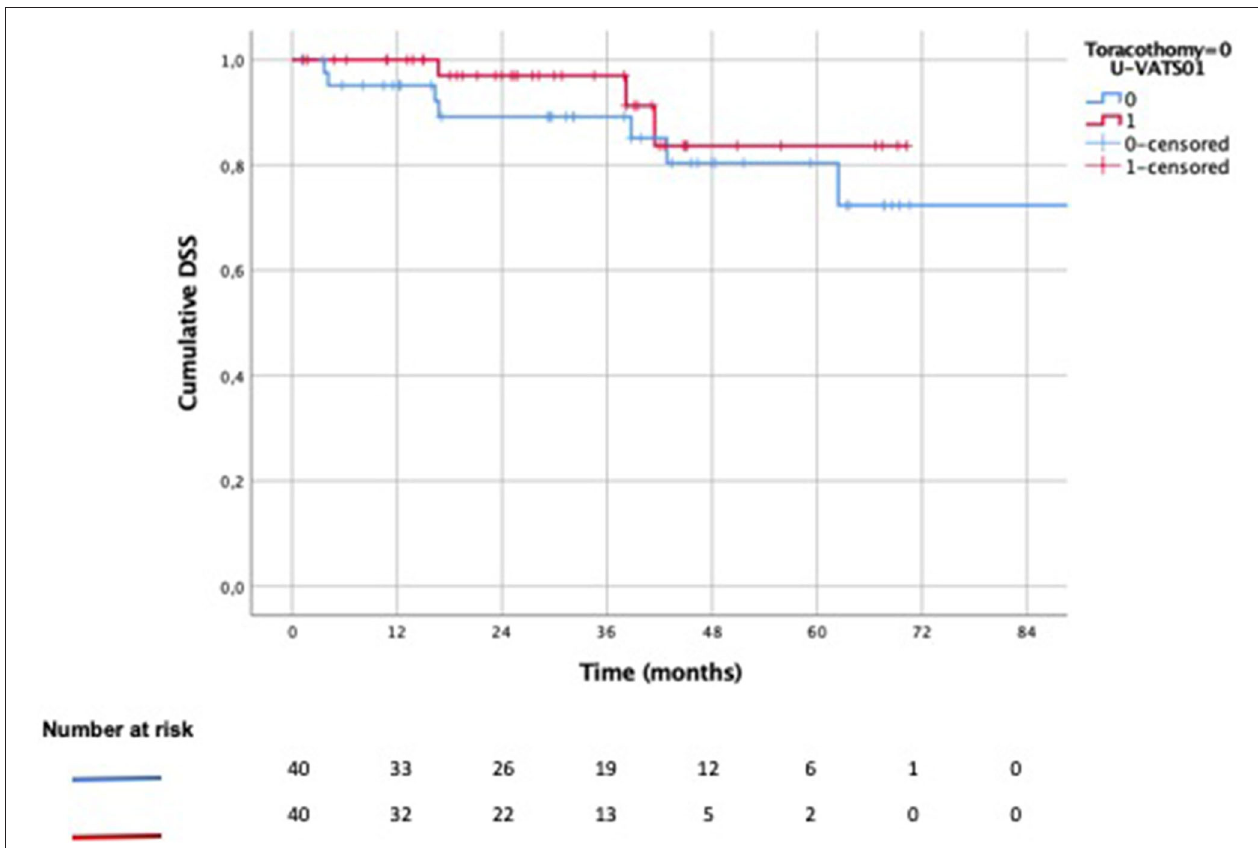
FIGURE 4 | Kaplain–Meier disease-specific survival (DSS)